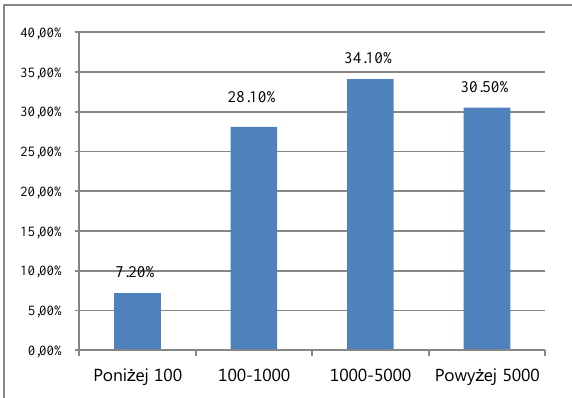
Figure 1. The number of individuals in Poland attempting suicide